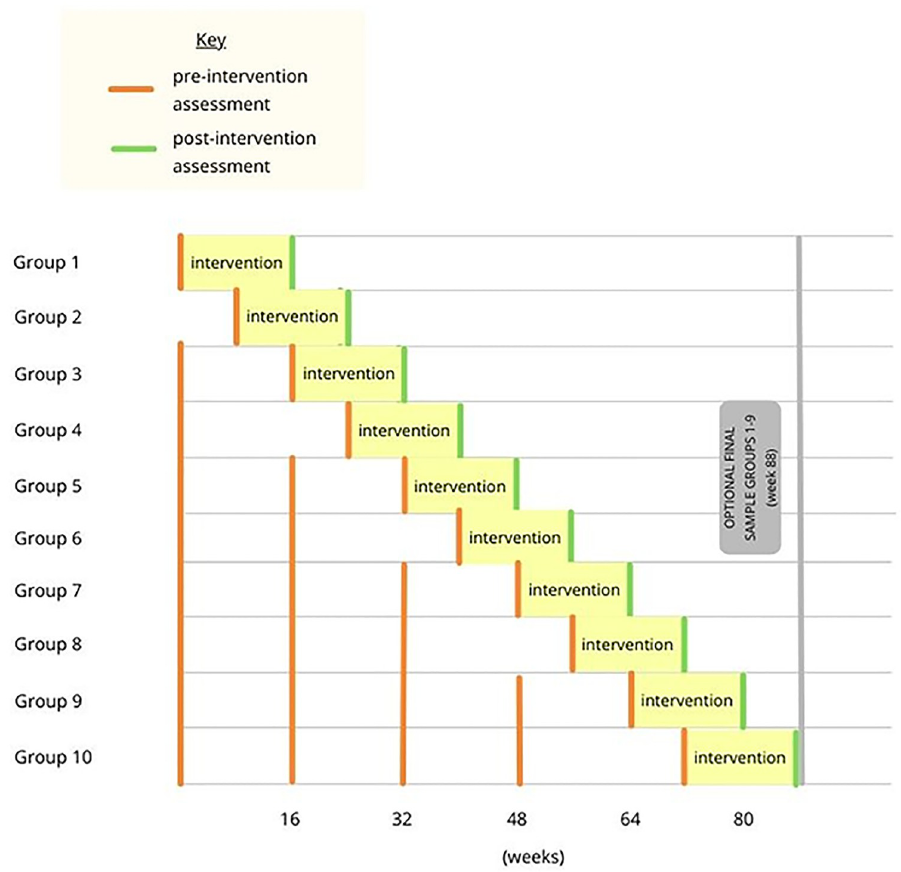
Fig 2. Graphical timeline of stepped